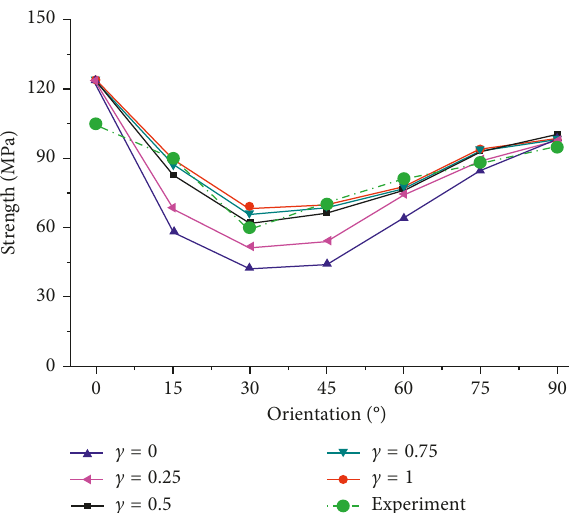
Figure 10: Numerical specimens with structural planes at different orientation: (a) α (f) α 75 ° ; (g) α (cid:29)